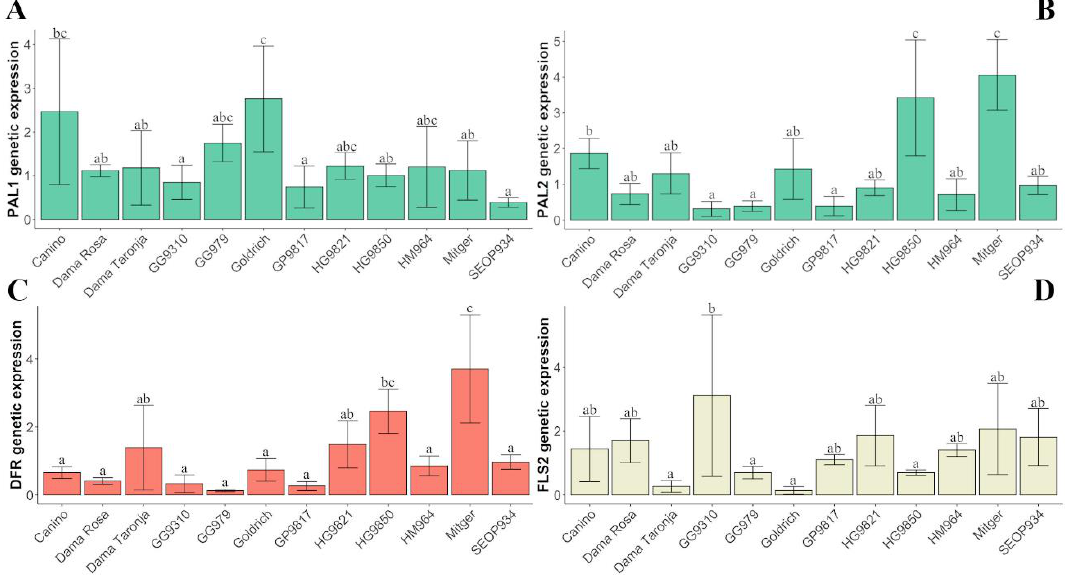
Figure 5. Genetic expression (average of both years of study) of ParPAL1 ( A ), ParPAL2 ( B ), ParDFR ( C ), and ParFLS2 ( D ). Bars represent standard deviation. Different letters represent statistically significant differences.